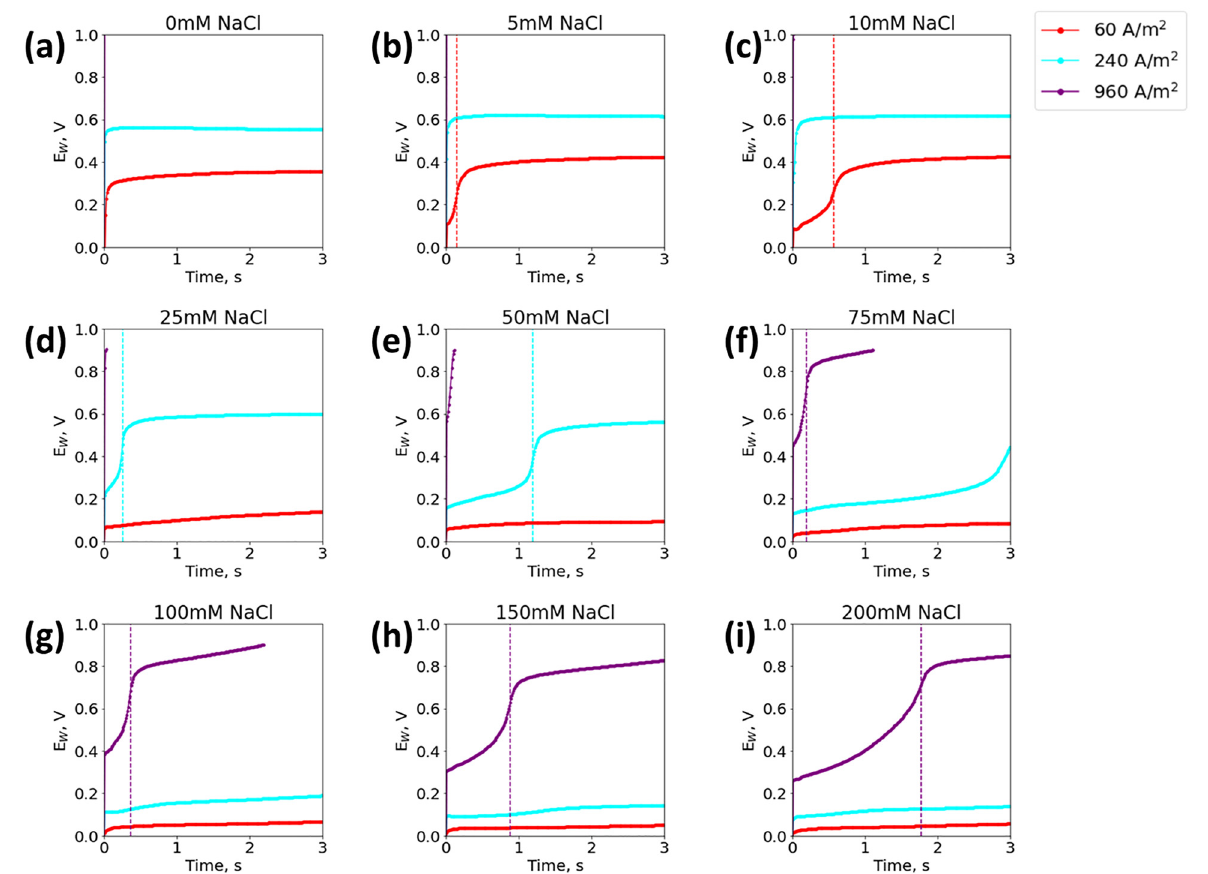
Figure 5. Chronopotentiogram of each mode of sweep test run in succession at 3 s for 960 A/m 2 ,480 A/m 2 , and 60 A/m 2 in 20 mM Na 2 SO 4 at 25 °C in NaCl concentrations of ( a ) 0 mM, ( b ) 5 mM, ( c ) 10 mM, ( d ) 25 mM, ( e ) 50 mM, ( f ) 75 mM, ( g ) 100 mM, ( h ) 150 mM, and ( i ) 200 mM. Vertical dotted lines in each plot indicate the transition time. Prior to each constant current density step, the system was run at OCP for 1 min.